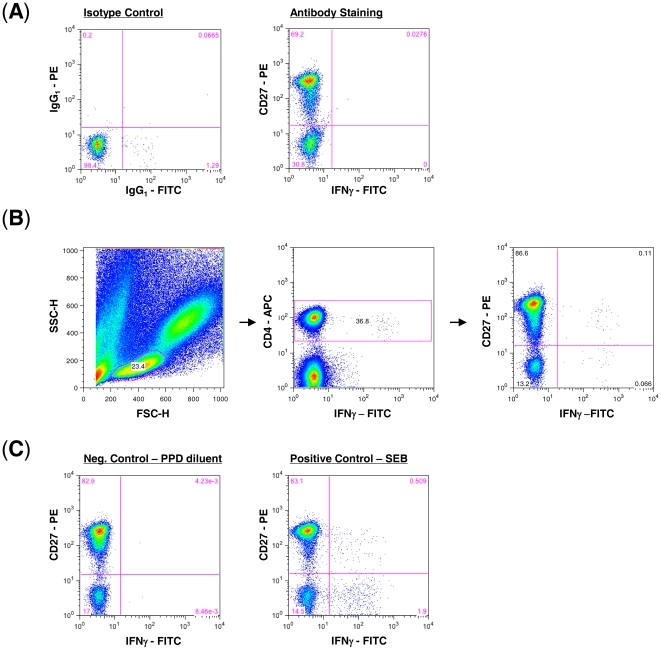
Characterization of CD27 expression on PPD-specific CD4 T cells in whole blood.(A) The cut off for CD27 expression was determined based on the corresponding isotype control for each antibody. Shown is a representative staining for IFNγ-FITC and CD27-PE as well as their corresponding IgG1 isotype controls that were used to determine the cut off. (B) Gating strategy to identify PPD-specific CD4 T cells and to analyse the CD27 expression on IFNγ-positive CD4 T cells after 6 h of PPD-stimulation during the cross-sectional study. (C) Representative staining for negative and positive controls using PPD diluent and SEB, respectively, for stimulation.